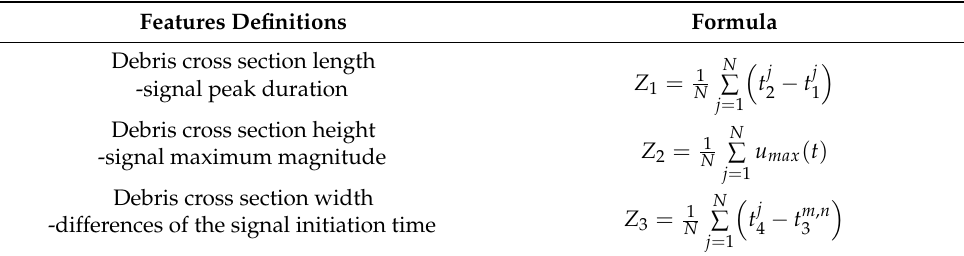
Figure 3. Anticipated features during debris encounter. Note: ( a , b ) side views as the cup trav- els across the orange rectangle debris, ( c ) front view of the cup’s sensing grid w.r.t. the debris, ( d , e ) definitions of the anticipated features. Table 1. Debris feature definitions (for j th sensing element, with total grid size of N